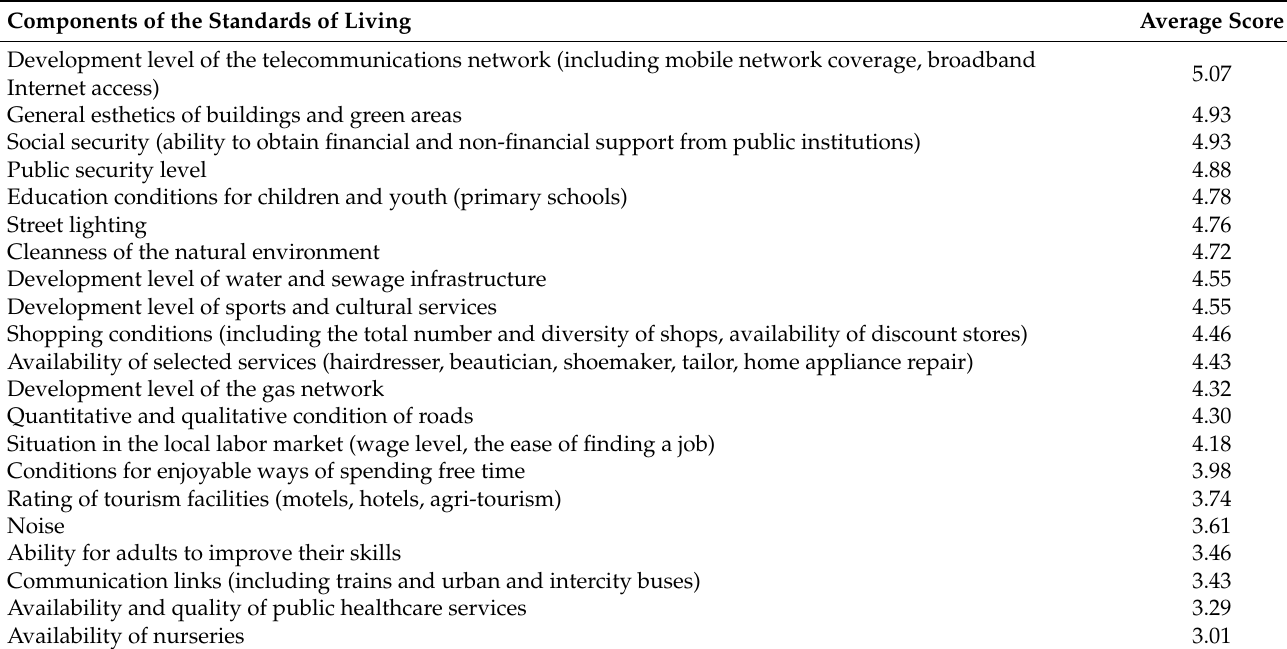
Table 5. Assessing the components of the standards of living at commune level.